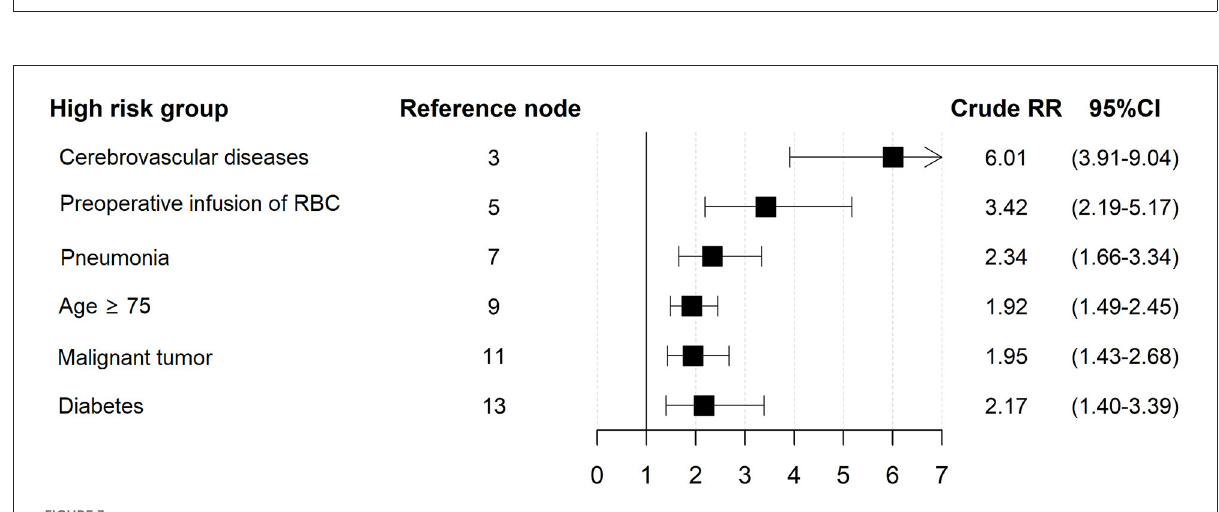
FIGURE3 Crude relative risks for pairwise nodes of the tree